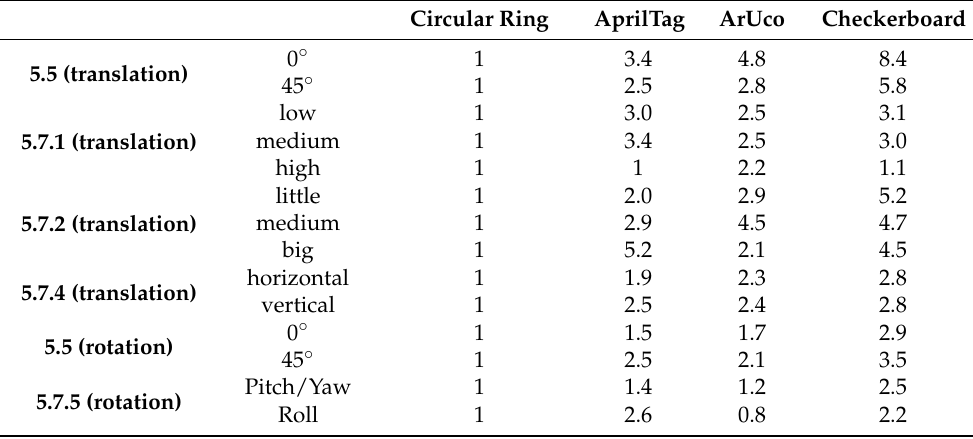
Table 11. The ratio of the average error of the different fiducial markers to the Circular-ring